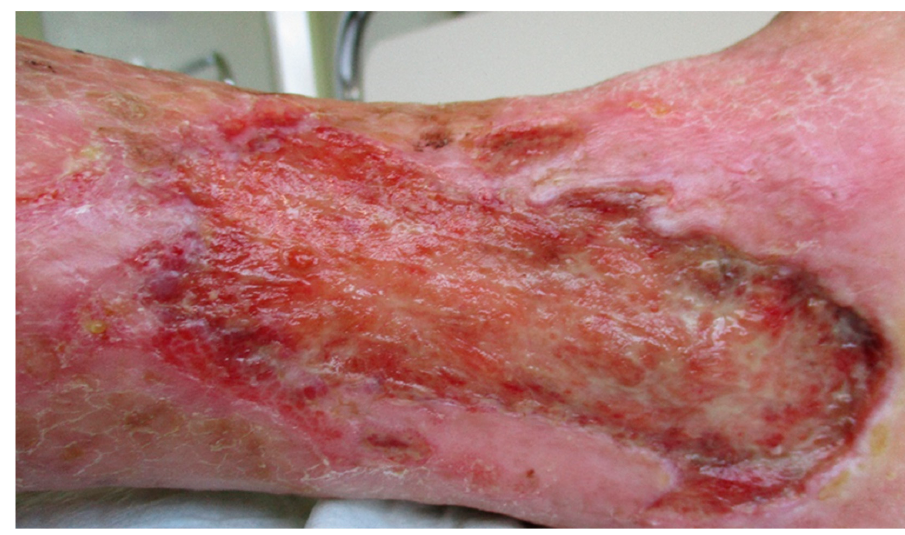
Figure 1. Venous leg ulcer before maggot therapy.